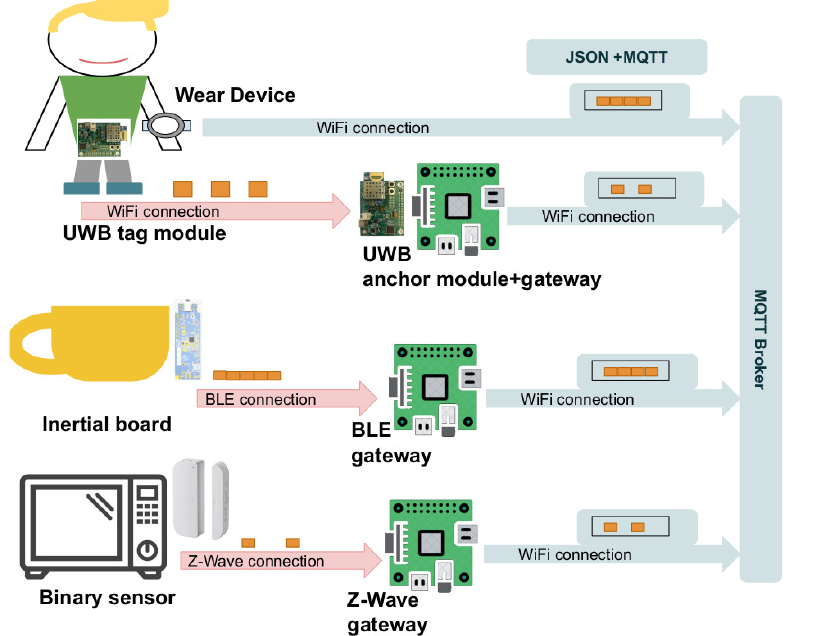
Figure 2. Architecture for connecting heterogeneous devices. Binary, location, and inertial board sensors send raw data to gateways, which collect, aggregate, and publish data with MQTT in JSON format. The Android Wear application collects, aggregates, and publishes the data directly using MQTT through WiFi connection.